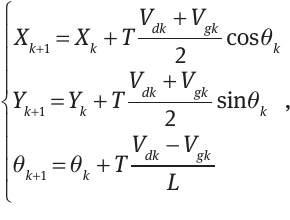
The global control system shown in Figure 2 is composed of four blocks and a hysteresis switch: